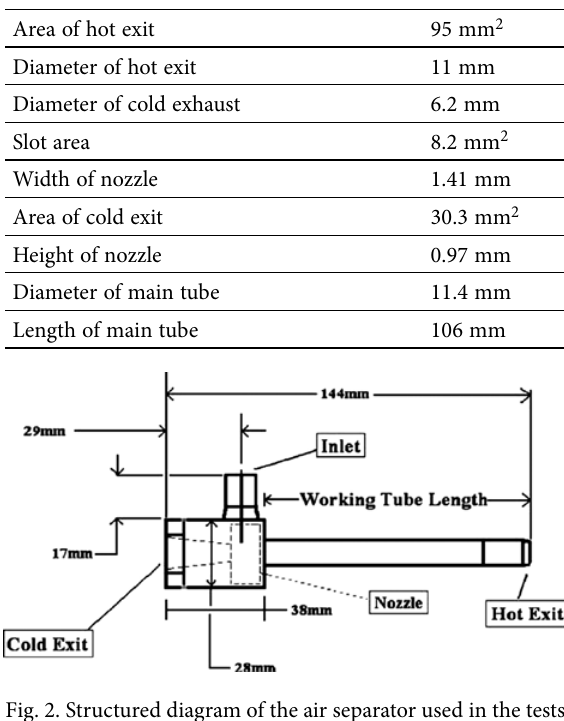
Fig. 2. Structured diagram of the air separator used in the tests In the computations, the velocity pressure coupling uses the SIMPLE algorithm. Also, the convective items have been discretized using the second order upwind scheme. The minimum value for the convergence